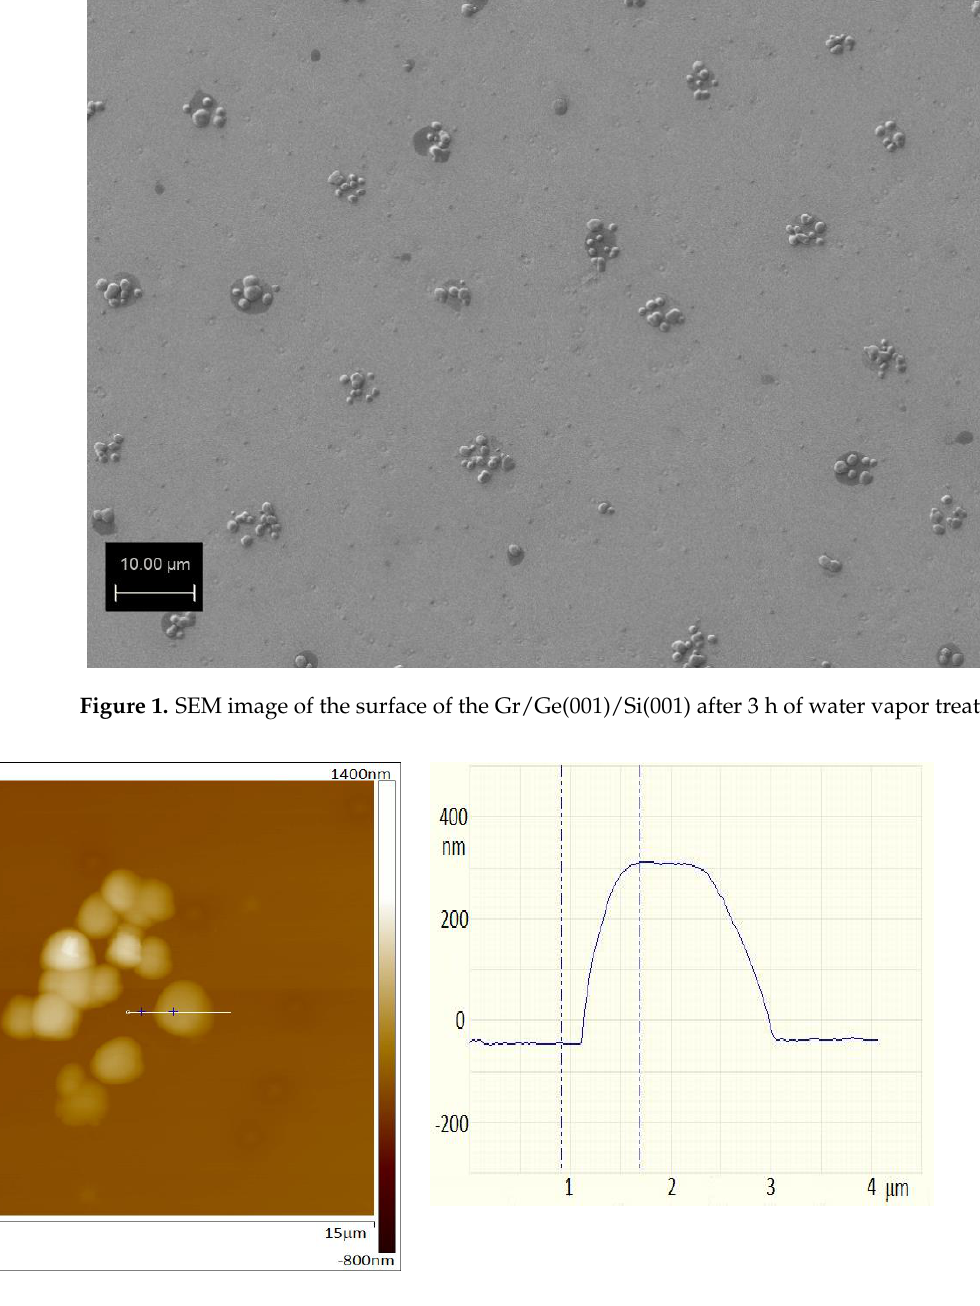
Figure 2. ( a ) AFM image of a group of spots on the surface of the Gr/Ge(001)/Si(001) sample after 3 h of water vapor treatment ( b ) AFM scan of one of the blisters showing that its surface is lifted up compared to the Ge(001) level.